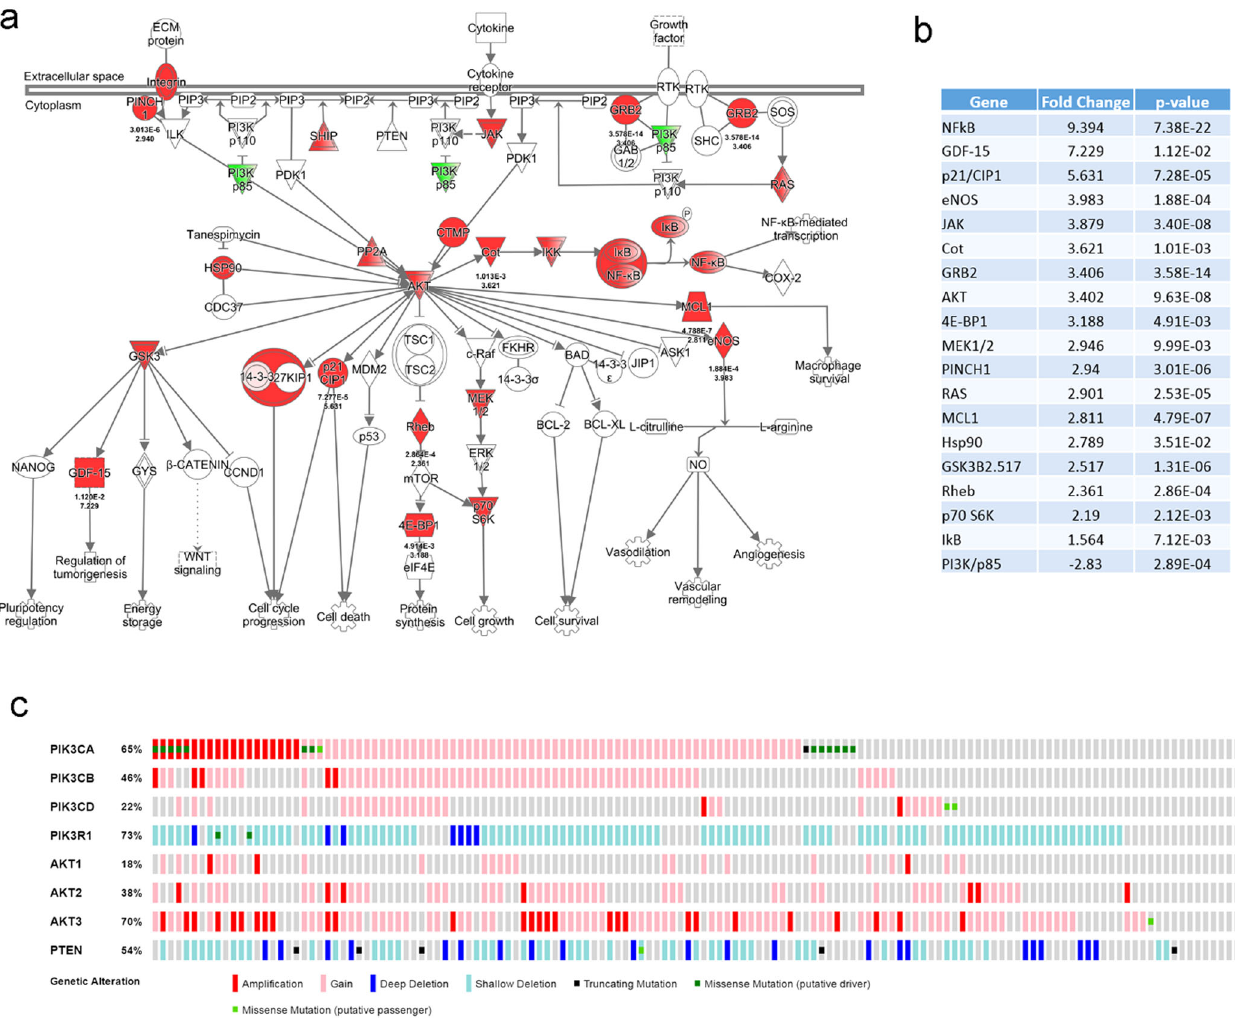
Fig. 1 a Pathway analysis of RNA-seq data comparing 94 TNBCs vs. 20 normal breast tissues reveals the overexpression of the PI3K/AKT pathway. Statistical analysis revealed 3,197 genes (FDR < 5%, with a fold change more than ± 2) that are differentially expressed between